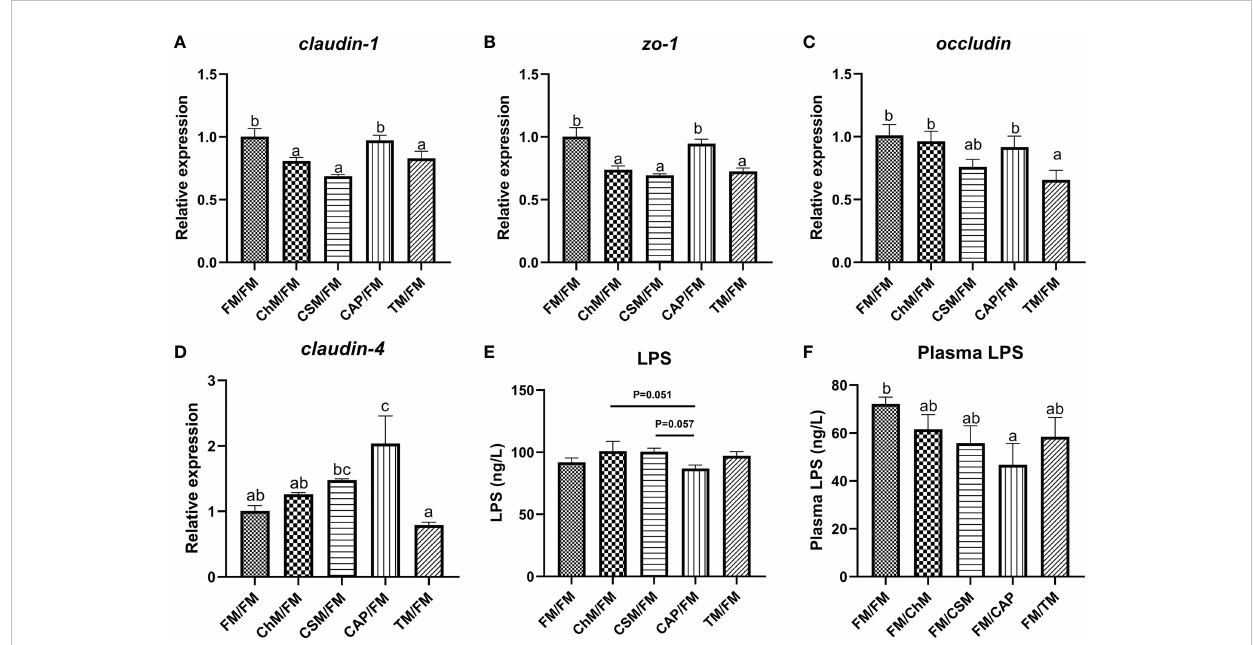
FIGURE 5 The intestinal physical barrier of juvenile largemouth bass under an alternate feeding strategy were shown as follows: claudin-1 (A) , zo-1 (B) , occludin (C) , claudin-4 (D) , intestinal LPS (E) , and plasma LPS (F) . Data are expressed as mean (S.E.M). Values on each column with different superscripts typi fi ed statistical differences ( P<0.05